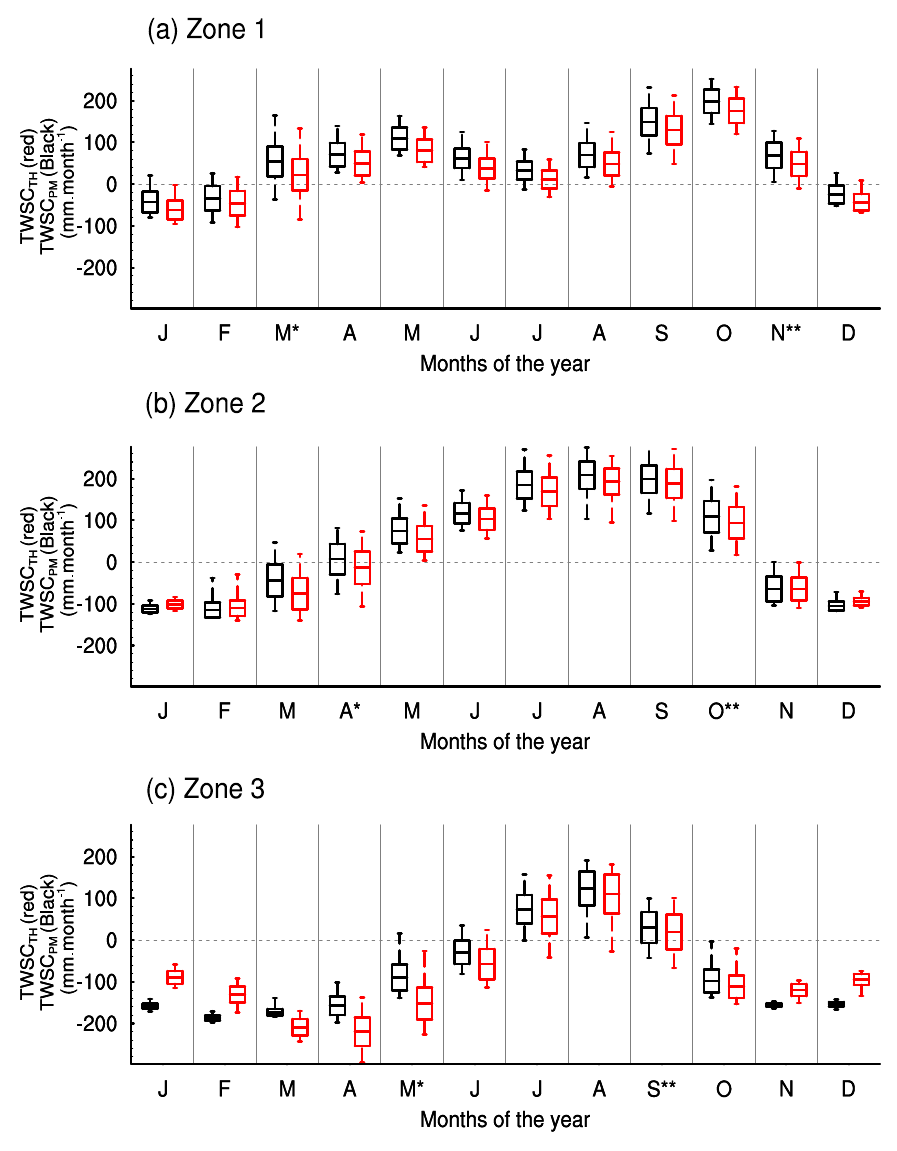
Figure 7. Box-plots showing annual cycles of TWSC TH and TWSC PM (expressed in mm · month − 1 ) for the period 1962–1993: ( a ) for the Equatorial forest zone named Zone 1 (south of study area); ( b ) for the transition zone between the Equatorial forest zone and the Sahel zone named Zone 2; and ( c ) for the Sahelian zone named Zone 3 (north of study area). The labels on the x-axis (J, F, ..., D) indicate the months of the year (January, February, ..., December) respectively. The months marked by one and two stars indicate the onset and retreat months of the rainy season, respectively. The parameters used to build a box are: mean TWSC (mid-value of box), mean + standard deviation (top value of box), mean − standard deviation (bottom value of box) and minimum and maximum TWSC (bottom and top values,